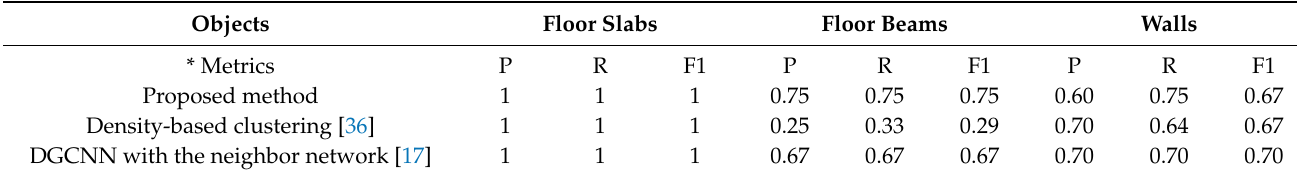
Table 3. Comparison among different segmentation methods.